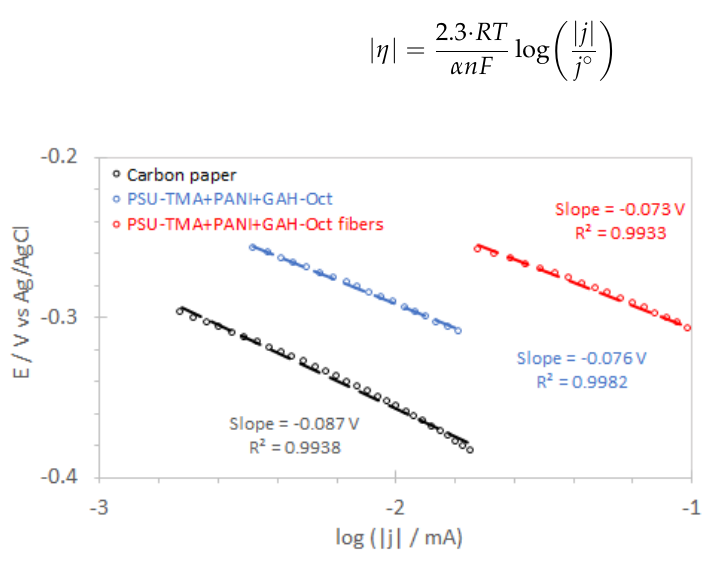
Figure 11. Tafel plots were obtained from LSV curves at 1500 rpm. Table 2. Electrochemical properties of ORR electrodes: half-wave potential E 1/2 , Tafel slope B,